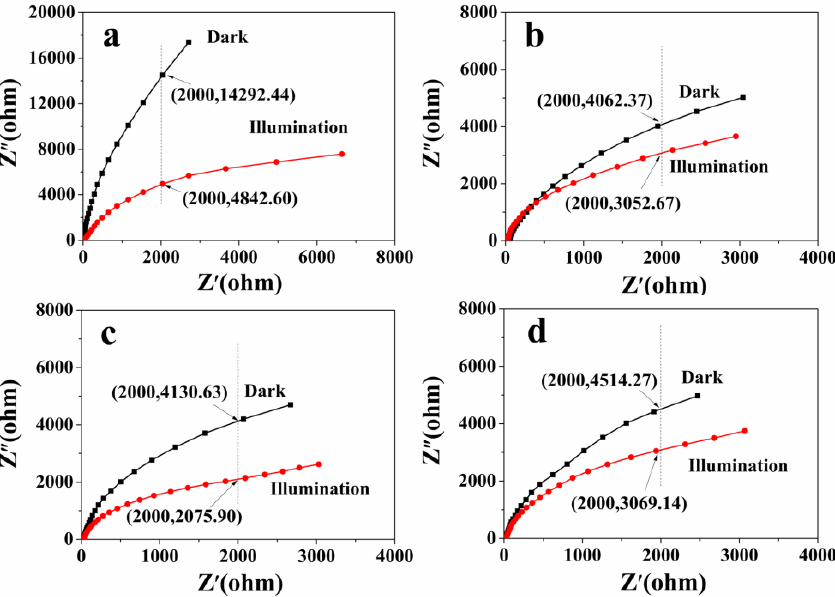
Figure 11. Electrochemical impedance spectra (EIS) Nyquist plots of the products prepared under different solvothermal reaction times: ( a ) 1 h; ( b ) 3 h; ( c ) 6 h; ( d ) 12 h.